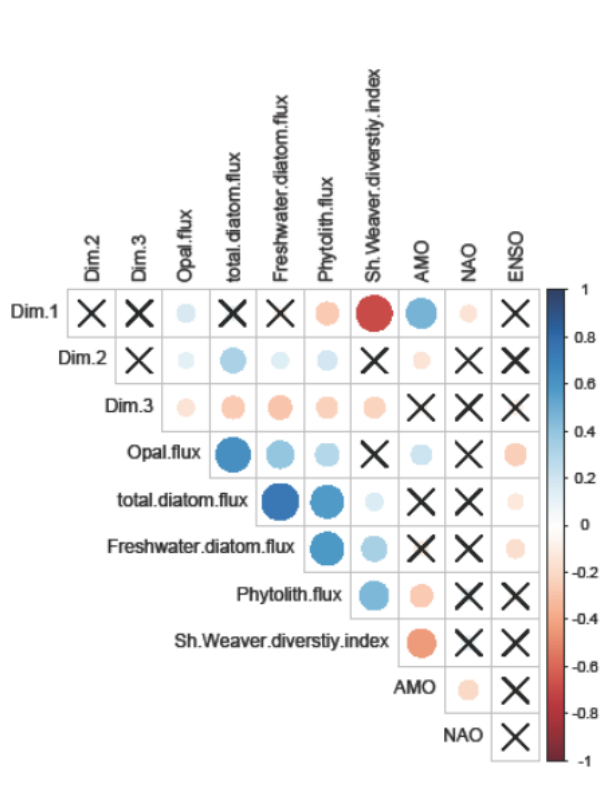
Figure 5. Correlogram representing Spearman’s correlation rank between CA axes (i.e., Dim.1, Dim.2, Dim.3), environmental vari- ables, and climatic and diversity indexes. Color scale and circle size indicate the strengths of the correlation. Squares without an “X” in- dicate significant relationships ( p value < 0.05). For interpretation of the references to color in this figure legend, the reader is referred to the web version of this